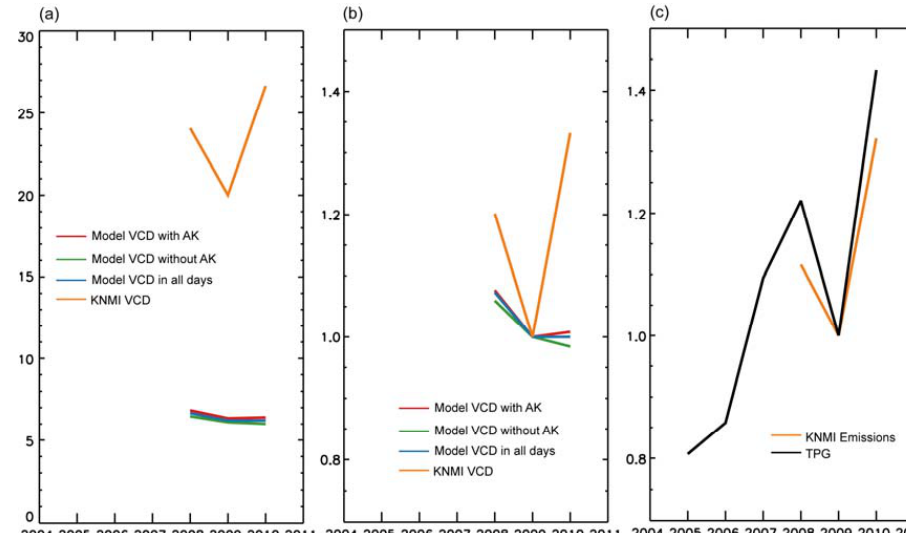
Fig. 8. Similar to Fig. 4 but for